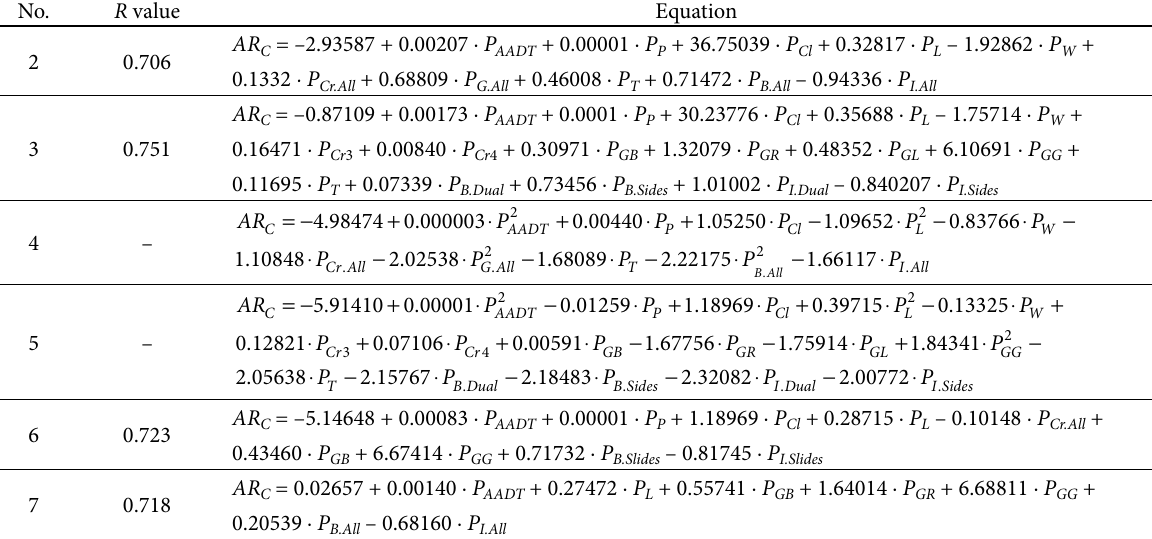
Table 7. Linear and multiple regression equations built using 90% of the analyzed data No. R value